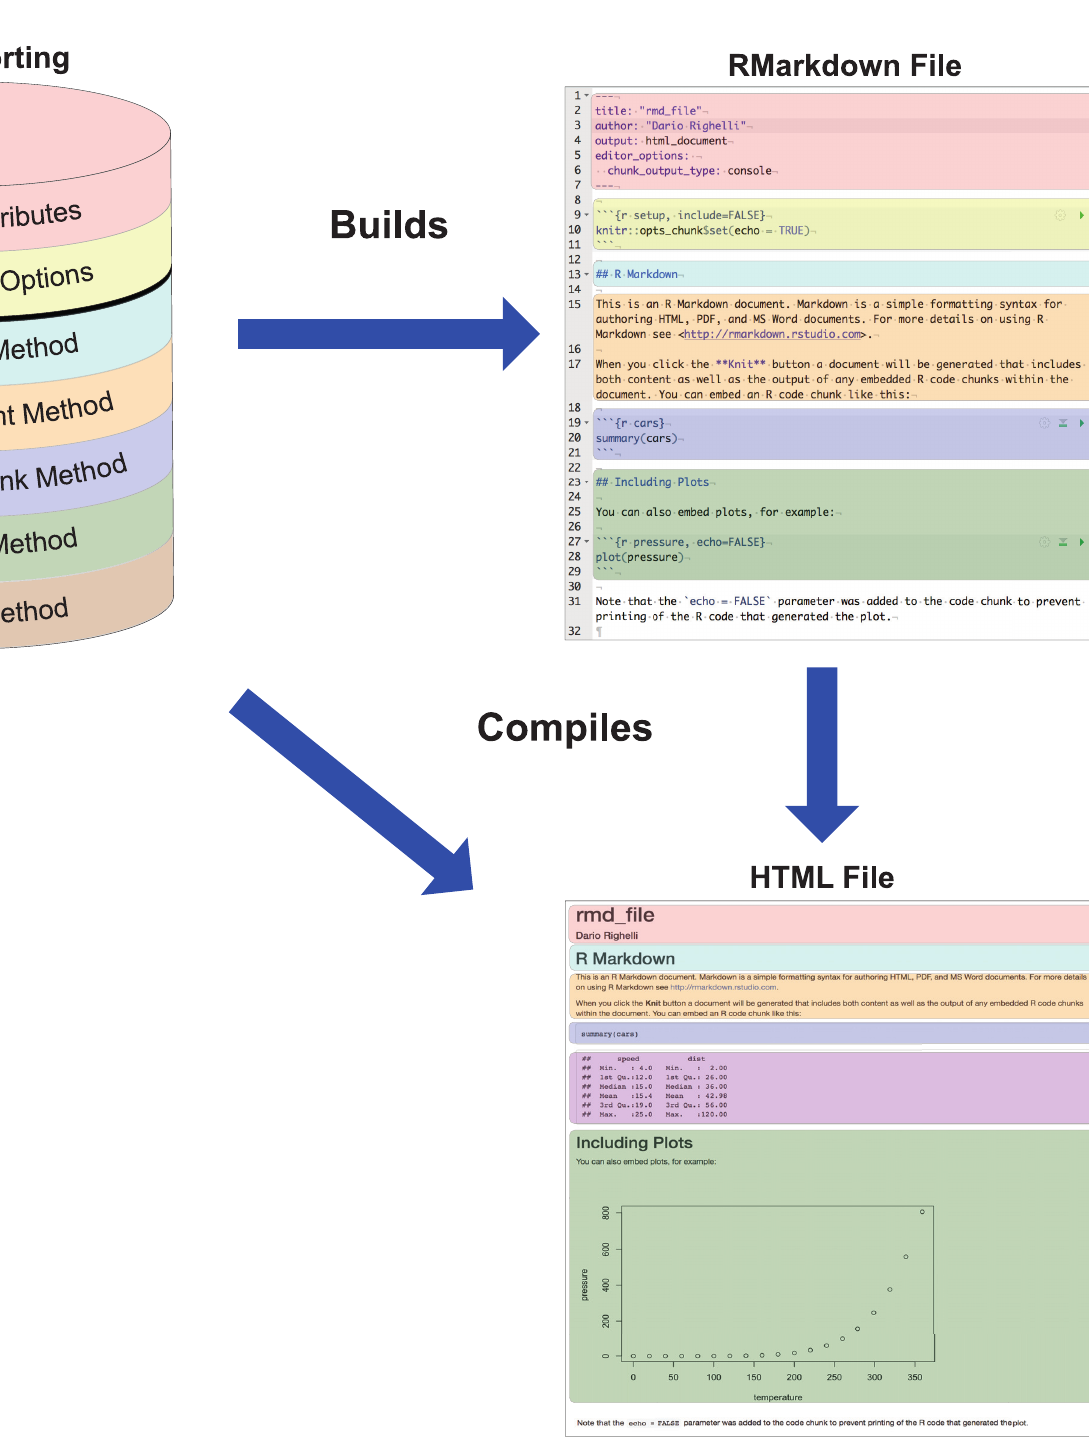
Fig 1. The easyreporting class package is a representation of a rmarkdown file. The color codes indicate which attribute/method represents the same-color portion of the rmarkdown first, and the compiled final report then (in this example an HTML file).